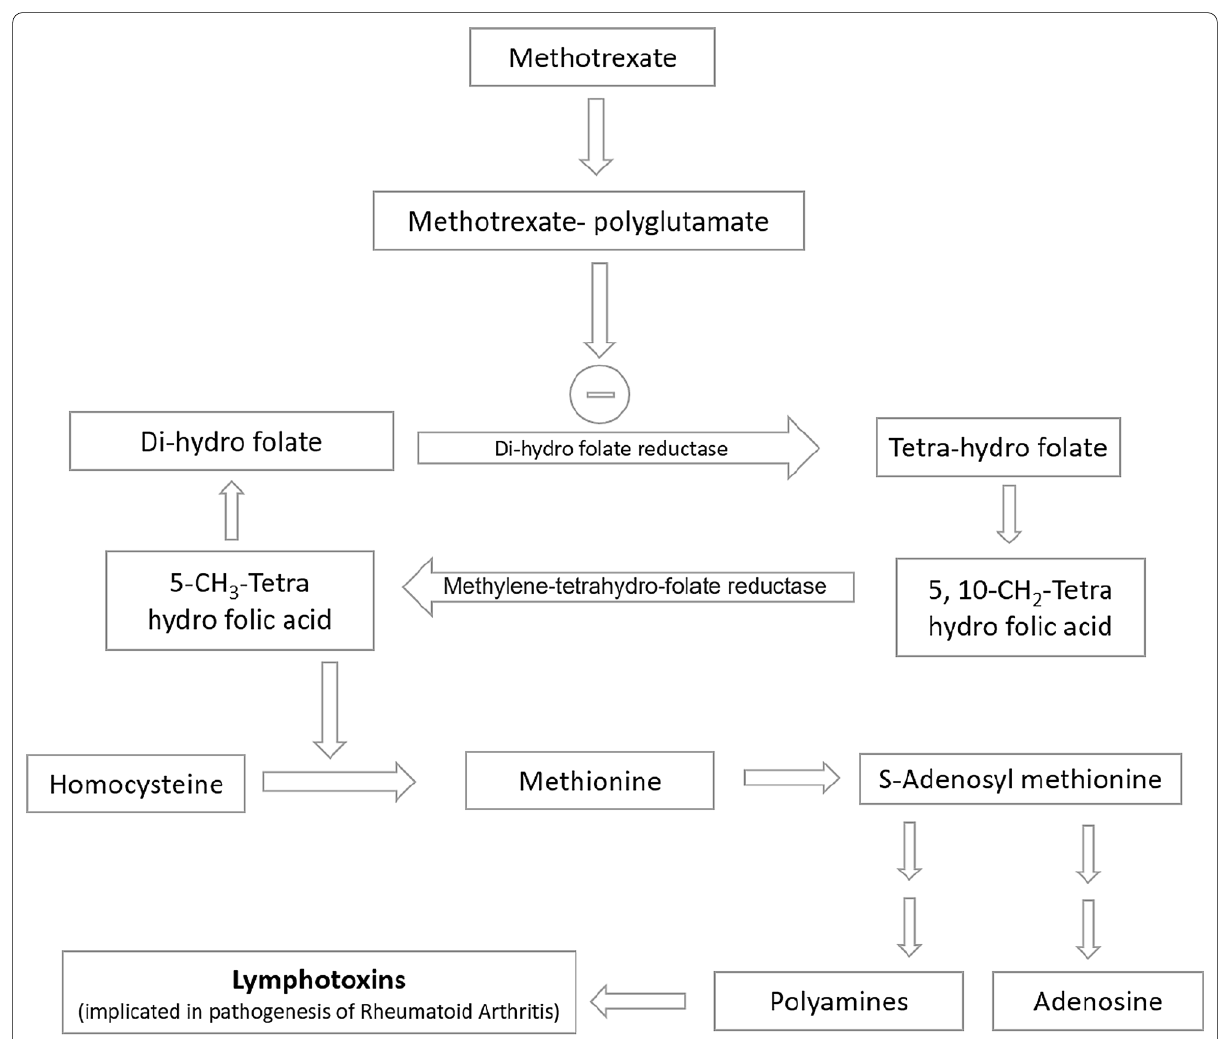
Fig. 4 Adenosine mediated inhibition of lymphotoxin and polyamine formation by